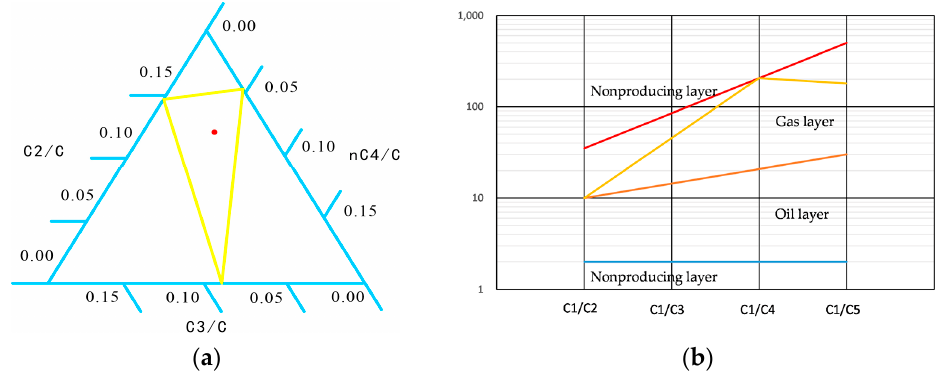
Figure 4. ( a ) The triangle diagram method; ( b ) Pixler chart. Table 2. The triangle diagram method judgment criteria.